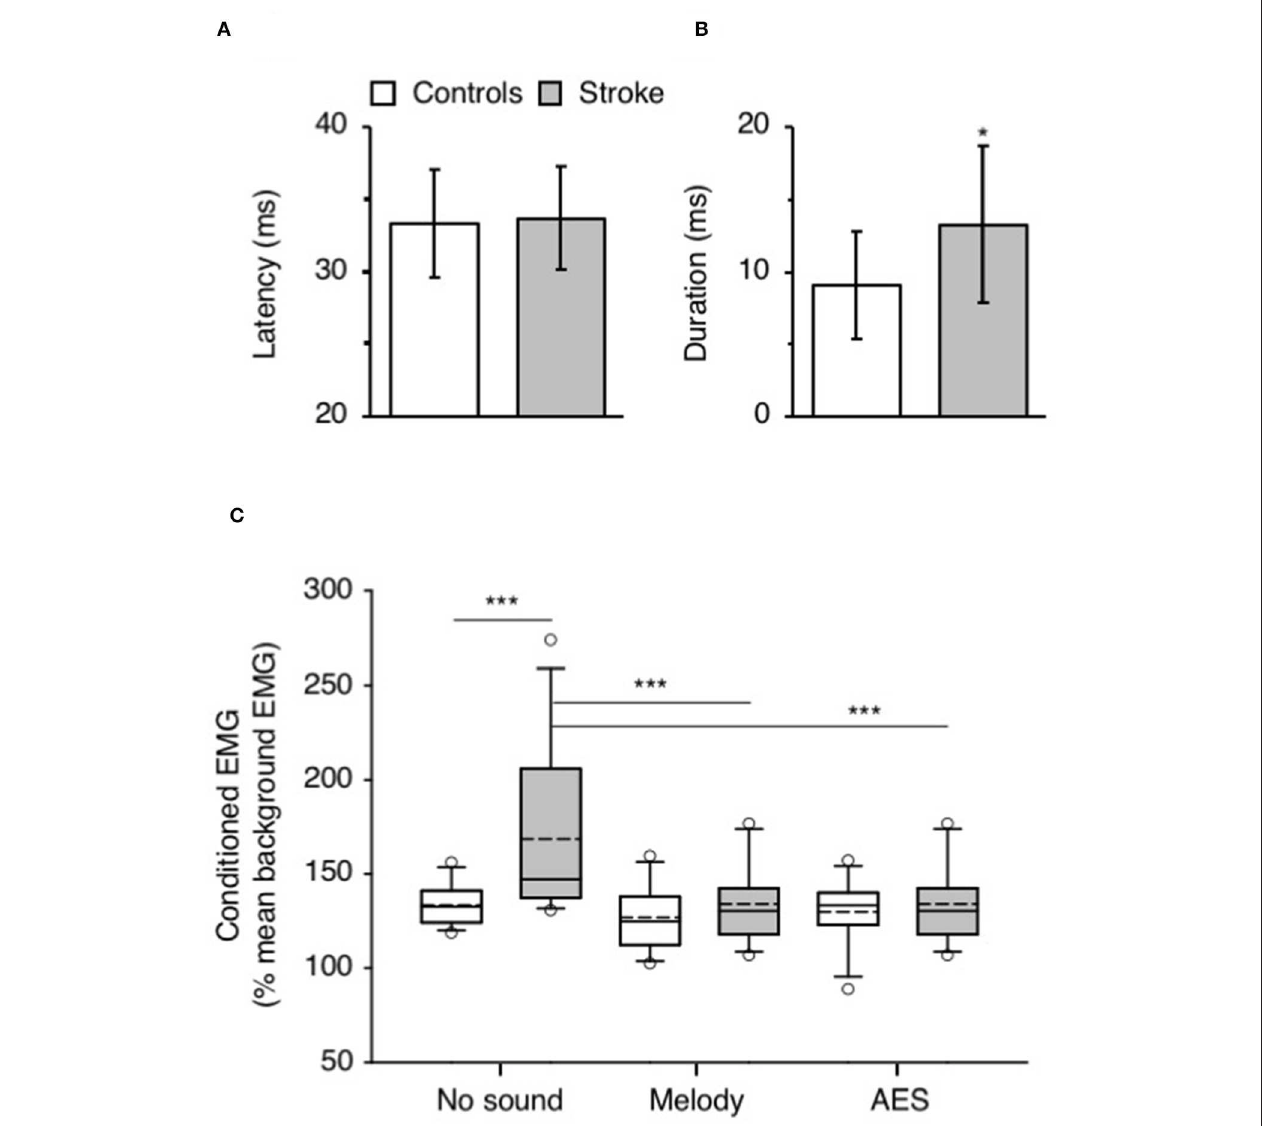
FIGURE 3 | Music-induced modulation of CPQ reflex. (A) Mean latency (ms) of CPQ reflex in controls (white column) and in patients with stroke (gray column). The vertical error bars indicate ± 1 × SD. (B) Mean duration (ms) of the CPQ reflex in both groups, same legend as in (A) . (C) Mean CPQ reflex expressed as the area of conditioned EMG (% mean unconditioned EMG) in the group of controls (white box; N = 12) and in the group of stroke patients (gray box; N = 12). The CPQ reflex was investigated during walking without sound and when listening to melody or AES. The box plot charts illustrate the data distribution in each condition. The boundary of the box closest to 0 indicates the 25th percentile (Q1), the continuous line within the box marks the median and the dotted line, the mean. The boundary farthest from 0 indicates the 75th percentile (Q3). The whiskers (error bars) above and below indicate the 90th and 10th percentiles, respectively. The open circles represent the 5% outliers. * p < 0.05, *** p < 0.001.